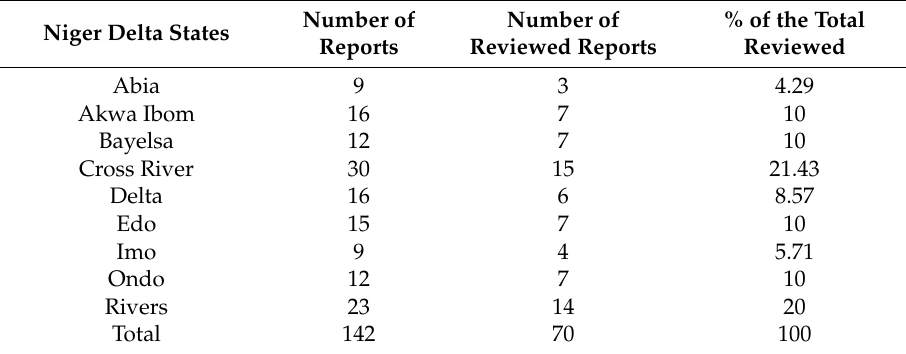
Table 5. State distribution of reviewed Niger Delta EIA reports.